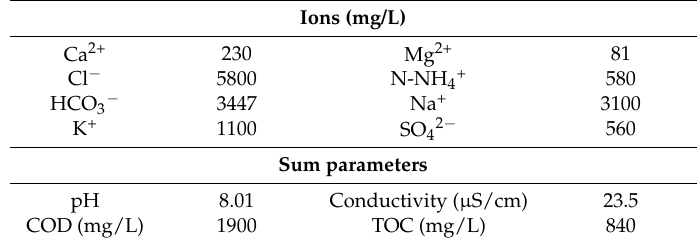
Table 2. Composition of raw leachate—major solutes (after analyses made by landfill